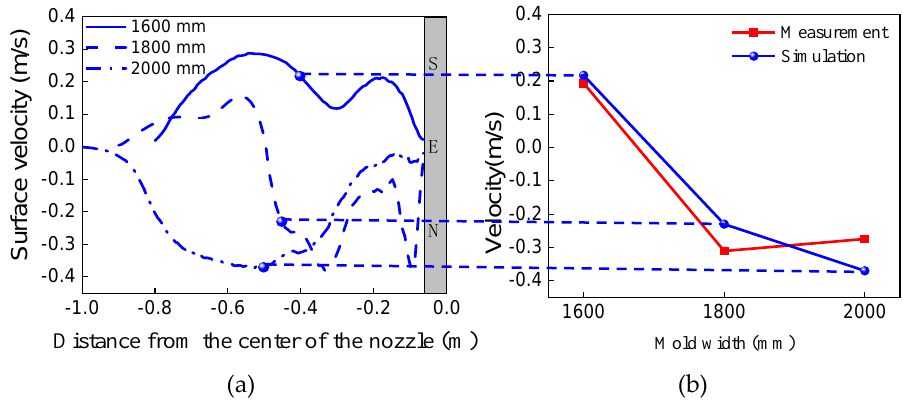
Figure 8. Surface velocity near the mold surface with different mold widths under the high fixed steel throughput ( a ) distribution in the width direction and ( b ) comparison between measured and calculated values.